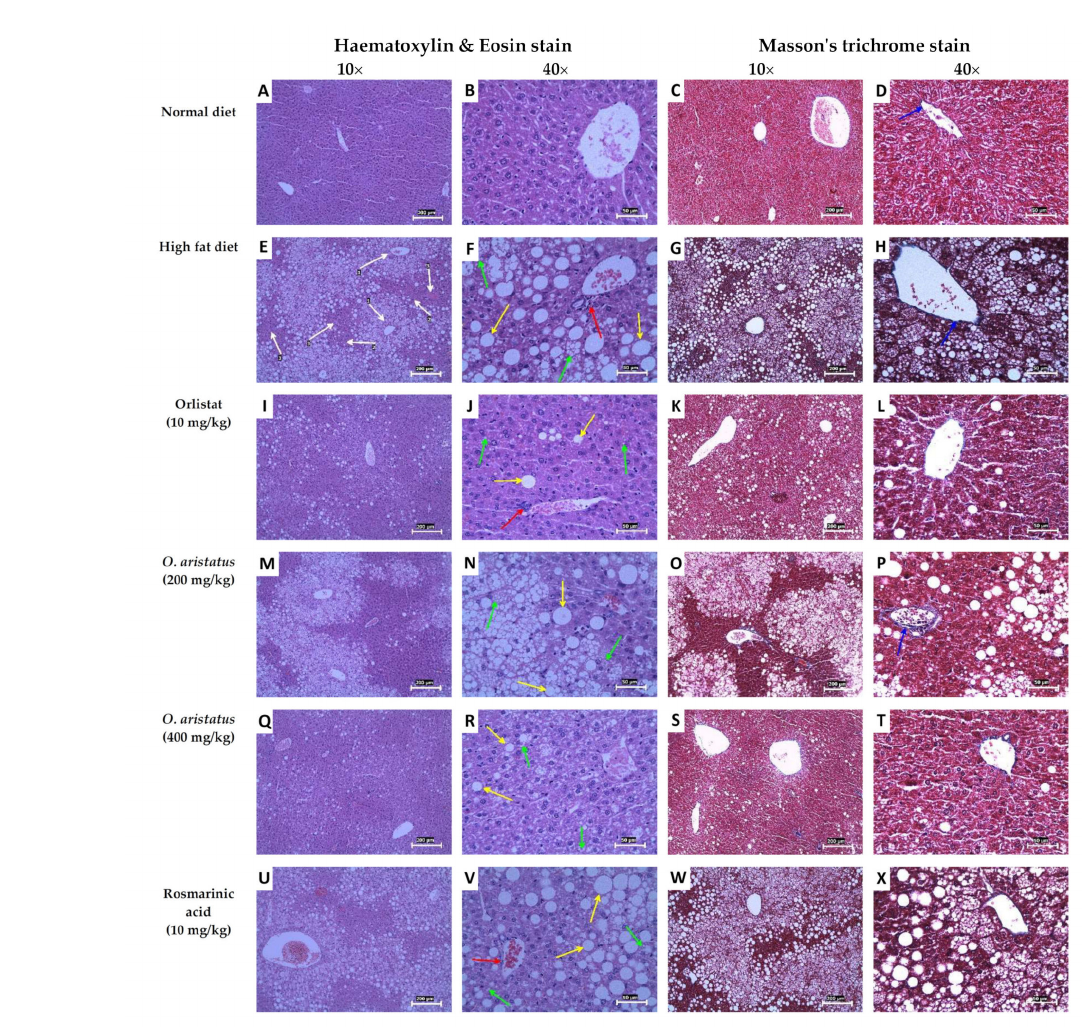
Figure 6. Hematoxylin and eosin and Masson’s trichrome staining of mice liver tissues. The yellow arrows indicate macrovesicular steatosis within hepatocytes, the green arrows indicate microvesicular steatosis, the red arrows indicate lobular inflammation and the blue arrows indicate the blue-stained areas that are the connective tissue of the portal tracts. The white arrows indicate the liver tissue zones, zone 1 encloses the portal vein (hepatic arteries), zone 3 lies around central veins and zone 2 lies in between. The 10 × scale bar is 200 µ m and the 40 × scale bar is 50 µ